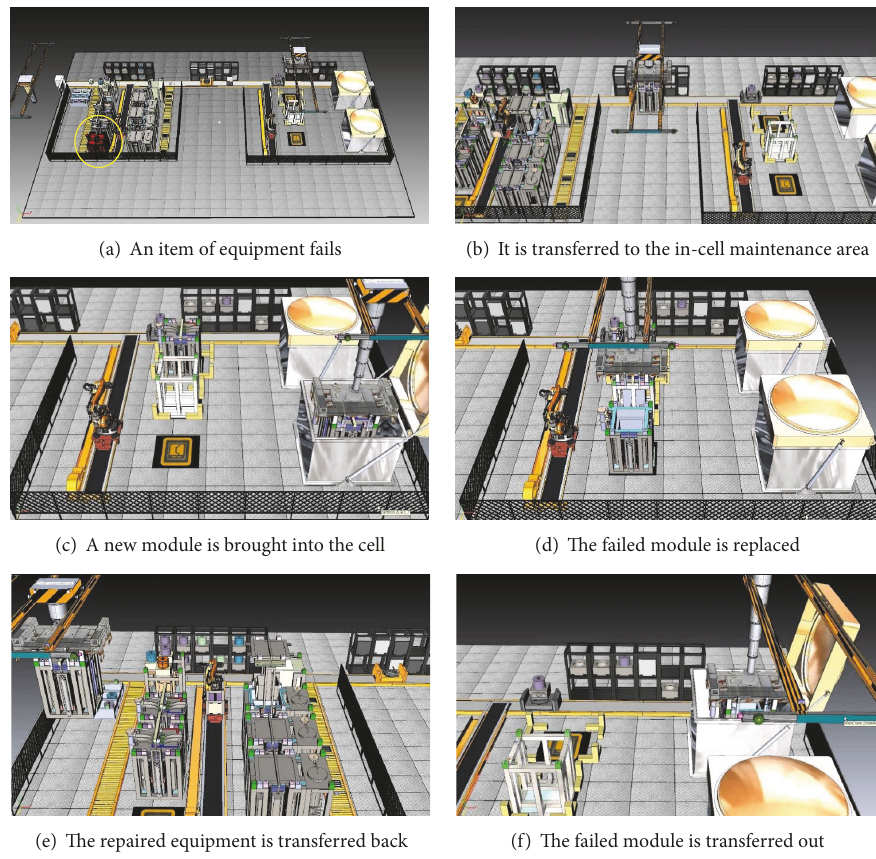
Figure 9: Maintenance automation procedure in the case of the reaction vessel